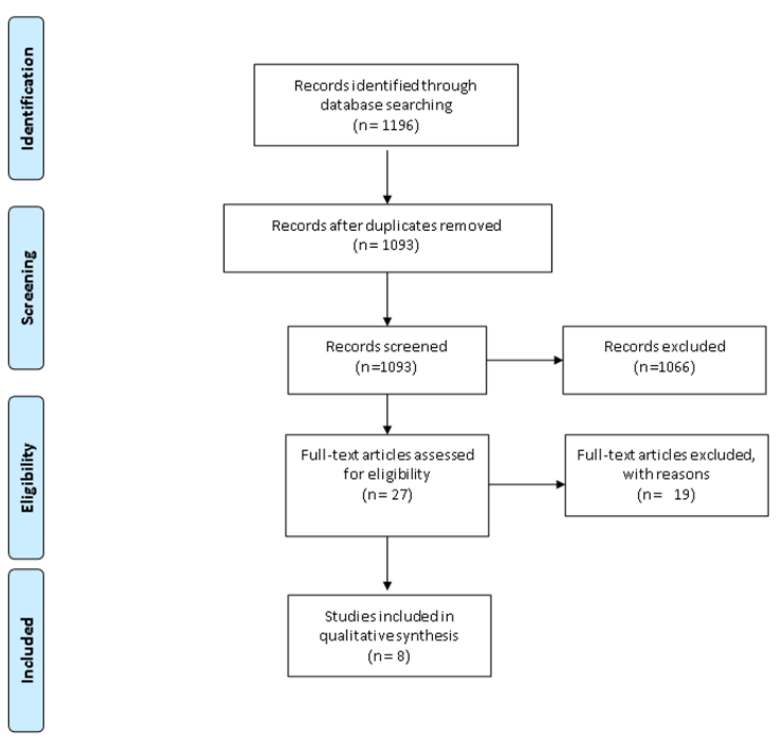
Figure 1. Flow diagram of information through the different phases of a systematic re-view.